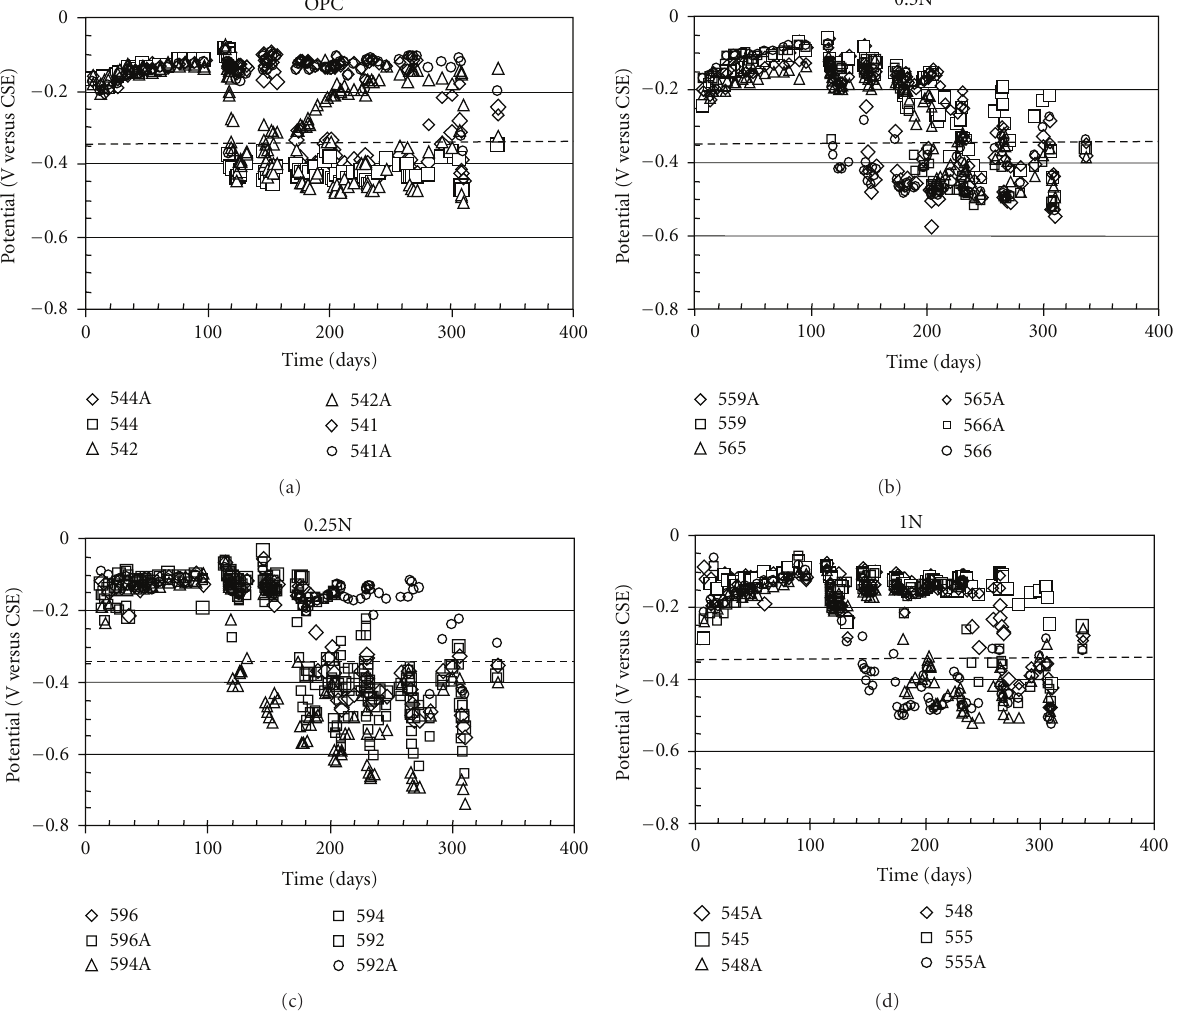
Figure 7: Average polarization resistance ( R P ) values versus time for all concrete electrochemical cells evaluated.